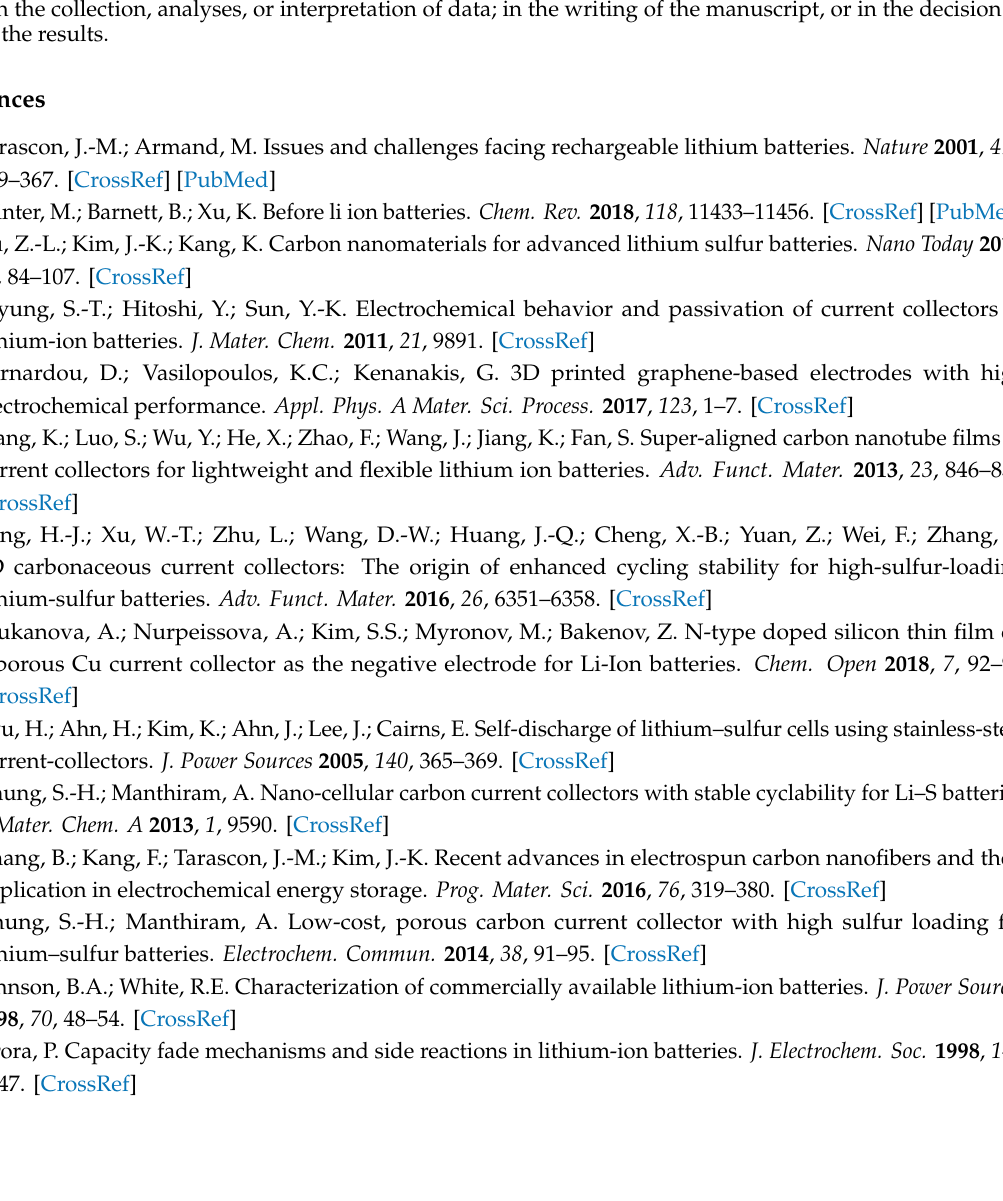
Figure S1: SEM images of (a) stabilized at 280 ◦ C, carbonized at (b) 600 ◦ C and (c) 700 ◦ C PAN12 nanofibers, Figure S2: (a, b) Potential profile and cycle performance of sulfur composite on the Al foil, and (c, d) on commercial CFs at 0.1 C, respectively, Figure S3: SEM image of sulfur based composite cathode on commercial CF current collector, Table S1: Diameter and void size of prepared